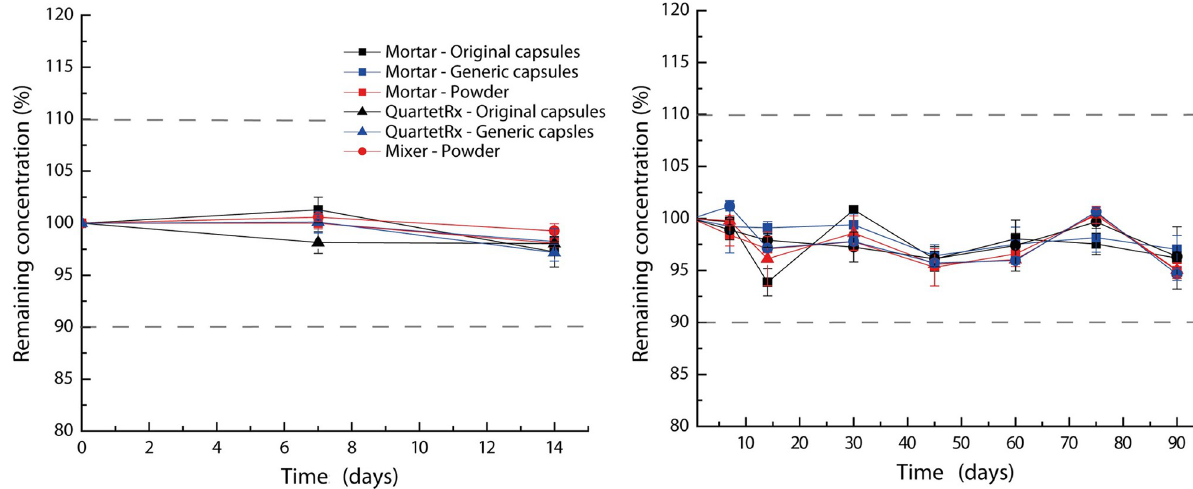
Fig 2. Chemical stability of HU oral liquids stored in amber oral plastic syringes (left) and amber plastic bottles (right). Initial concentrations (mg/ mL): mortar—original capsules, 93.0 ± 0.5; mortar—generic capsules, 96.2 ± 1.4; mortar—powder, 97.2 ± 0.4; mixer—powder, 100.9 ± 0.7; QuartetRx—